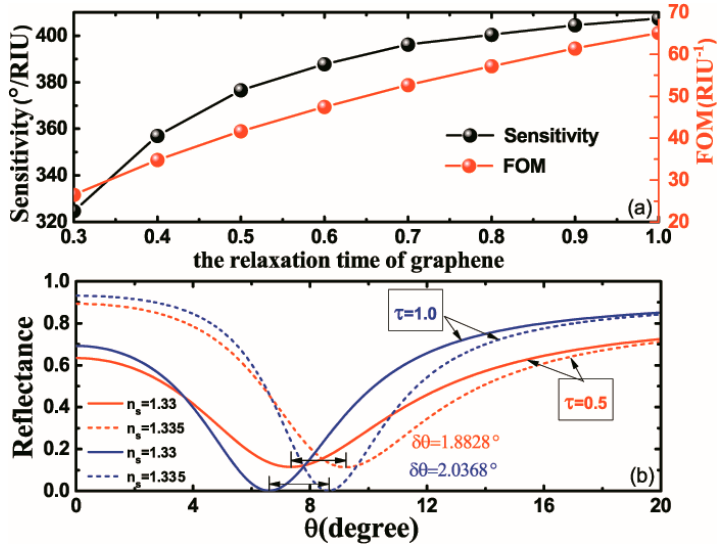
Figure 5. ( a ) The sensitivity and FOM of the proposed structure with respect to the relaxation time of graphene varying from 0.3 ps to 1.0 ps. ( b ) The reflectance as a function of incident angle at τ = 0.5 ps and τ = 1.0 ps; the Fermi energy is set to E F = 1.0 eV; other parameters are the same as those in Figure 2.